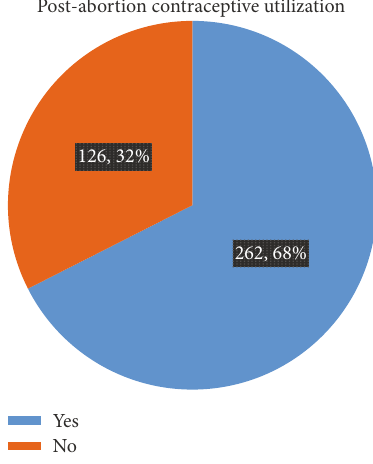
Figure 1: Postabortion contraceptive utilization among women who received abortion care services at health facilities in Ambo town, Oromia region, Ethiopia, 2021.